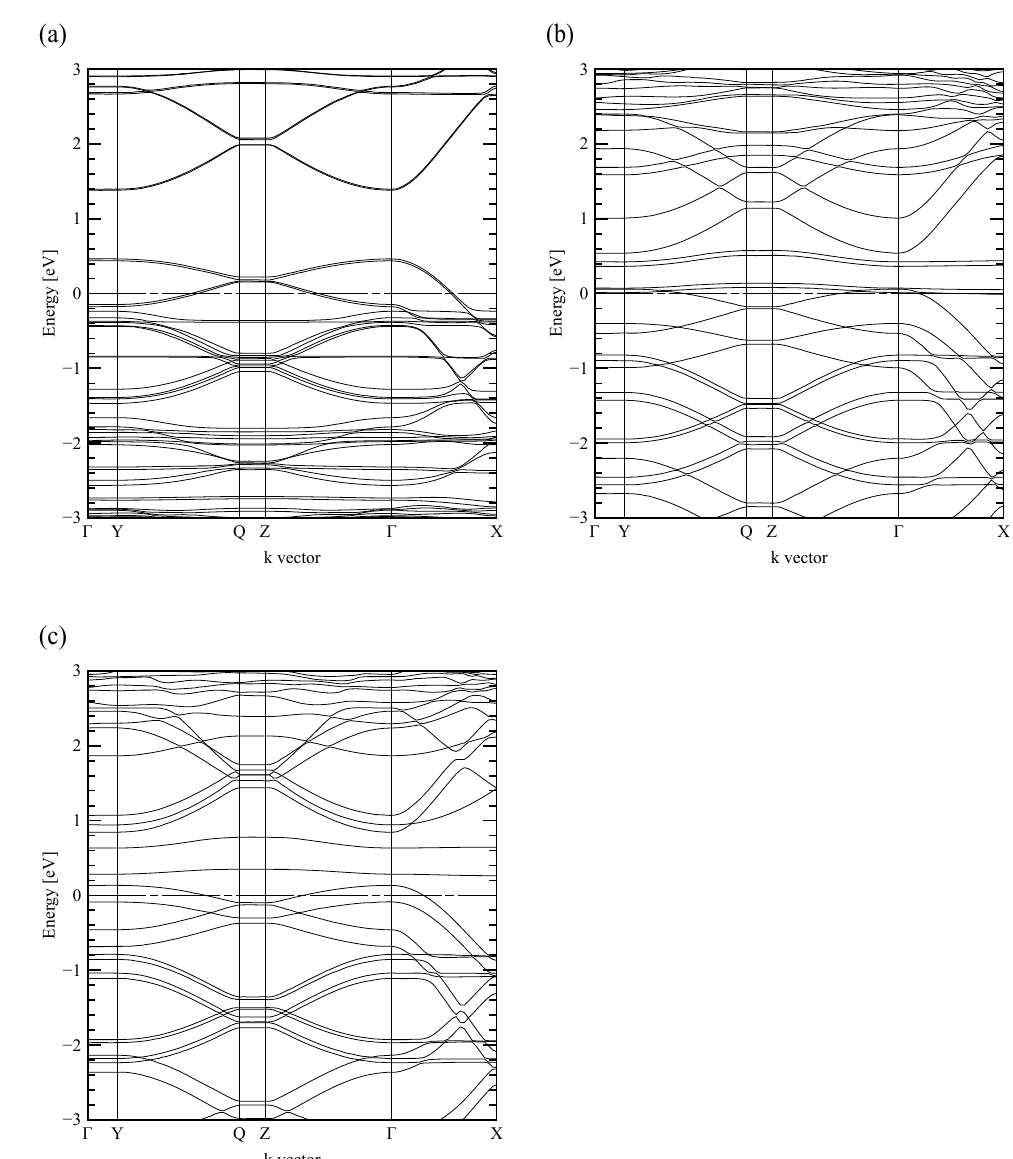
Figure 2. Band structure of ( a ) PEDOT:Tos, ( b ) highly doped PEDOT:PTSA, and ( c ) poorly doped PEDOT:PTSA. The Fermi energy is at 0 eV. The high-symmetry k-points in the first Brillouin zone are Γ = (0, 0, 0), Y = (0, 0.5, 0), Q = (0, 0.5, 0.5), Z = (0, 0, 0.5), and X = (0.5, 0, 0).